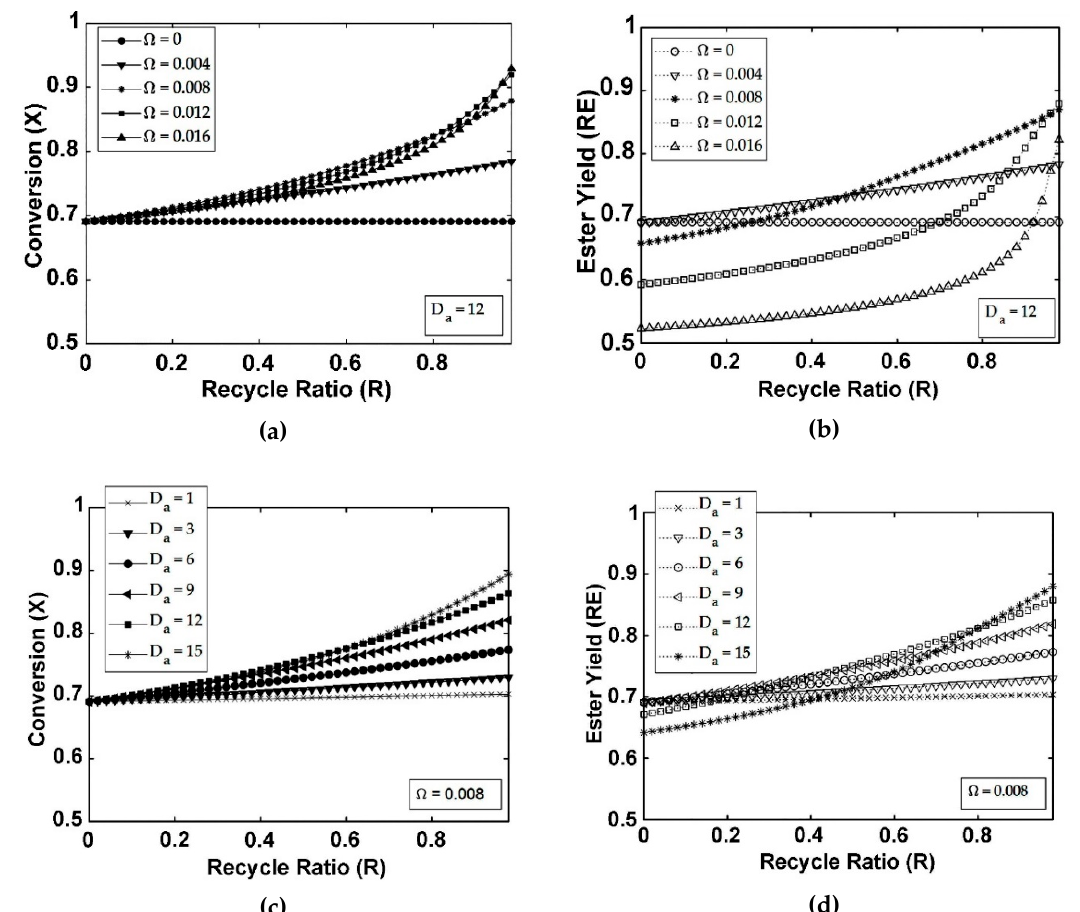
Figure 3. Influence of the R recycle ratio on isoamyl alcohol conversion and ester yield in a FBR+PVMU ( Configuration 1 ), as a function of the Ω parameter ( a , b ) and the D a Damköhler number ( c , d ).